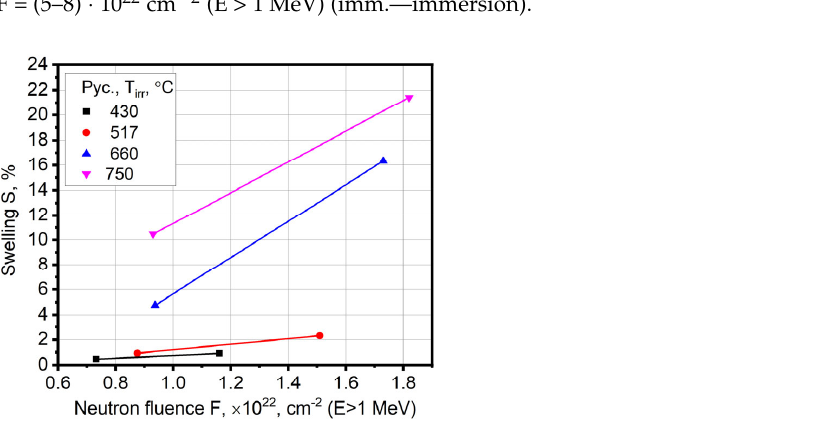
( b ) Figure 9. Small bubbles ( a ) and big pores ( b ) in microstructure of cast Be irradiated at 517 °C to F = 1.51 ∙ 10 22 cm − 2 (E > 1 MeV) and 750 °C to neutron fluence of 1.82 ∙ 10 22 cm − 2 (E > 1 MeV), accordingly (optical microscopy). The two ‐ phase structure of the irradiated cast Be ‐ 7Ti material contains coarse grains of the TiBe 12 phase with thin interlayers of the Be phase (Figure 10a). There is no noticeable rearrangement of the Be ‐ 7Ti phase structure compared to that before irradiation [26]. The volume fraction of the Be phase in the Be ‐ 7Ti specimens is 16–18%. Irradiation at 750 °C